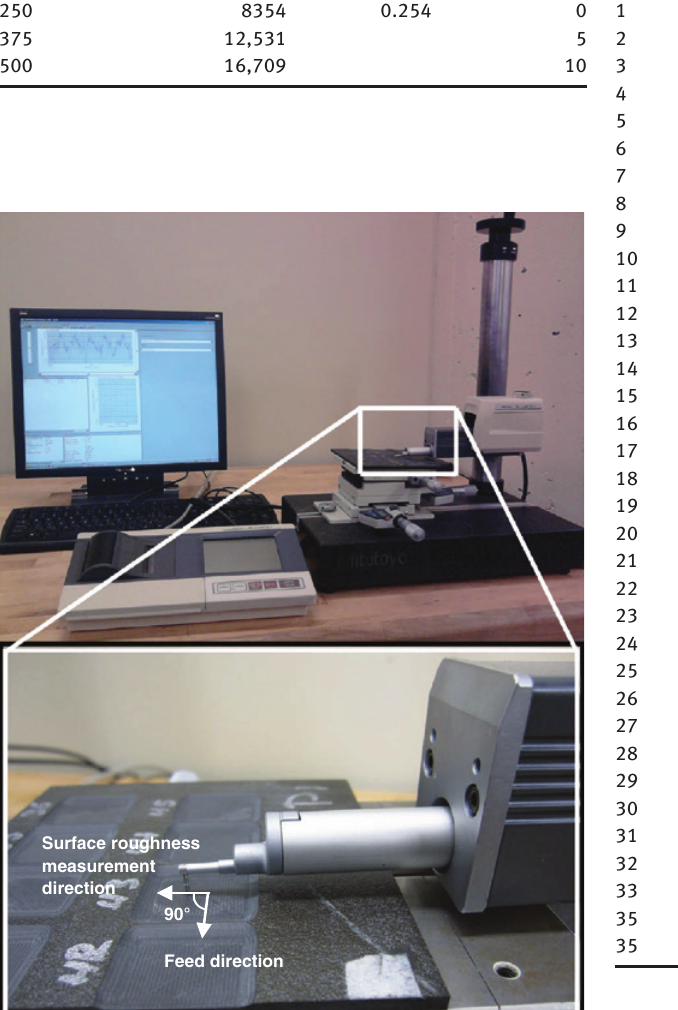
Figure 4: Measuring of surface roughness.